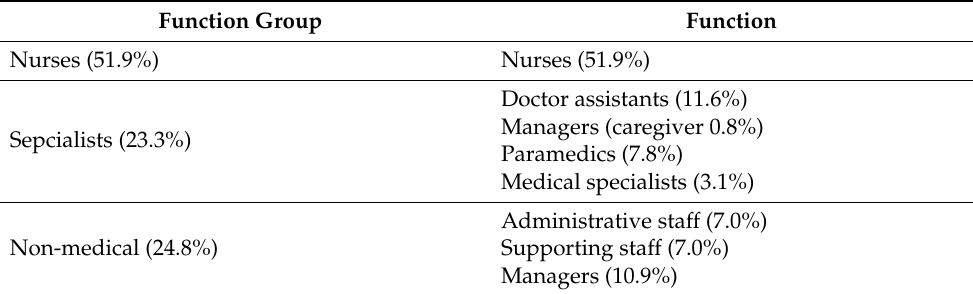
Table 1. Overview of